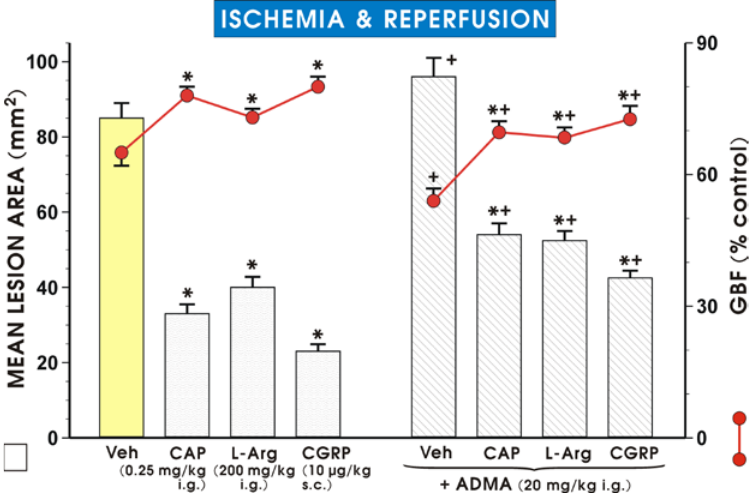
Figure 3. Mean lesion area and the changes in gastric blood flow (GBF) after application of a small “protective” dose of capsaicin (CAP, 0.25 mg/kg i.g.), L -arginine ( L -Arg, 200 mg/kg i.g.) or CGRP (10 µg/kg s.c.). Each was applied alone and in combination with ADMA (20 mg/kg i.g.), followed by exposure to ischemia/reperfusion. Results are mean ± S.E.M of 6–8 rats per group. Significant change ( p < 0.05) as compared with the respective values in the vehicle-control group, is indicated by an asterisk. A cross indicates a significant change ( p < 0.05) compared to the values obtained in the vehicle-control group. An asterisk and a cross indicate a significant change ( p < 0.05) as compared to the values obtained in rats treated with vehicle, capsaicin, L -arg, or CGRP without